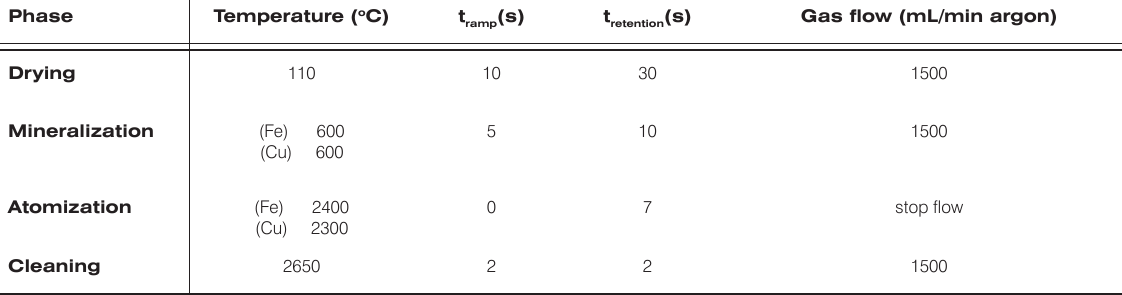
Table 1. The temperature program for the determination of Cu and Fe by GFAAS method.